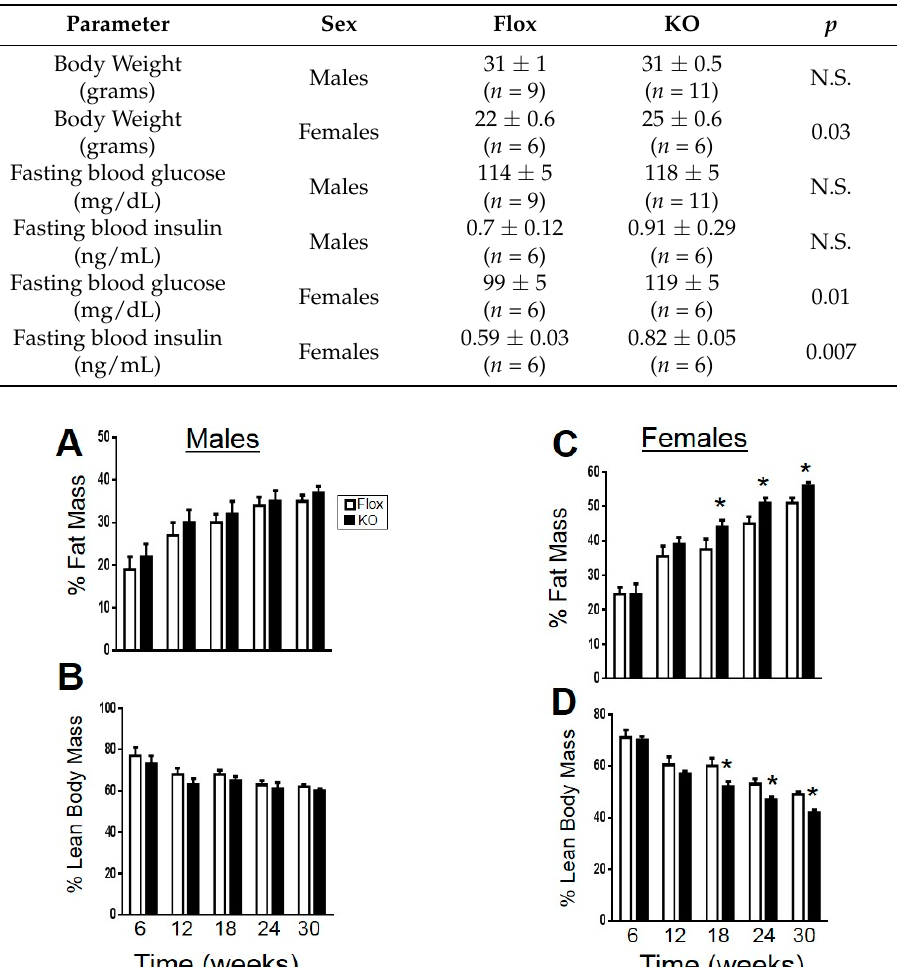
Table 1. Body weight and fasting blood glucose in Flox and KO mice fed a normal fat diet for 30 weeks. N.S. = not statistically significant.